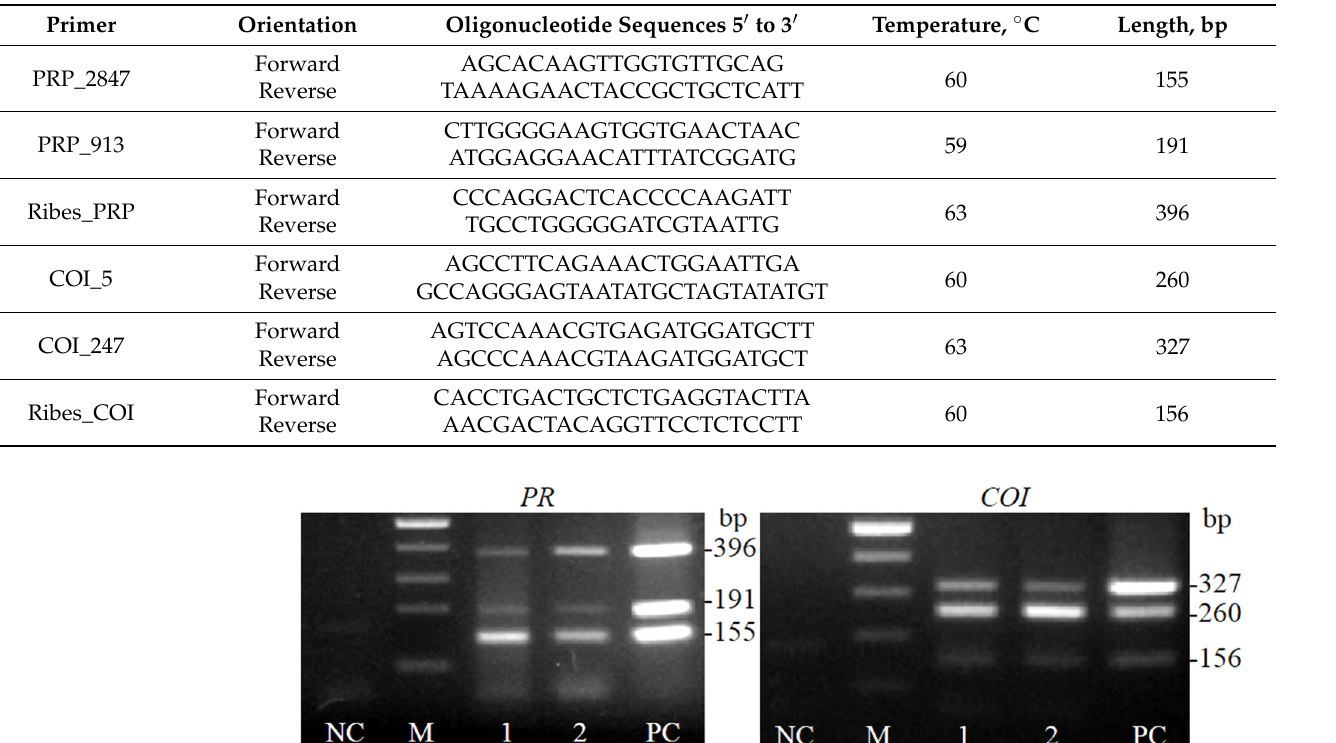
Table 2. Specific PR and COI primer pairs for Ribes spp.